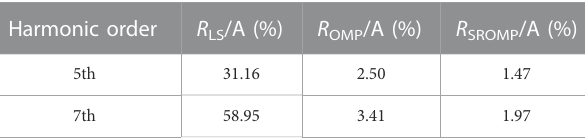
TABLE 4 Relative error. Harmonic order